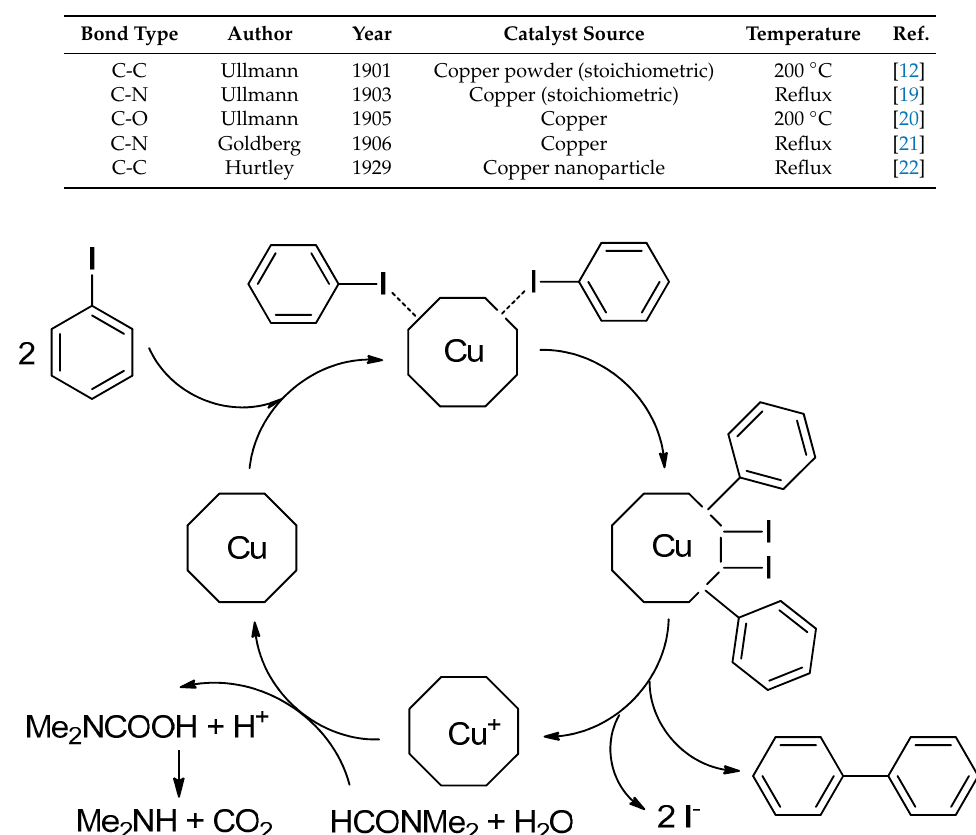
Table 1. History of Ullmann-type reaction by Ullmann, Goldberg, and Hurtley.